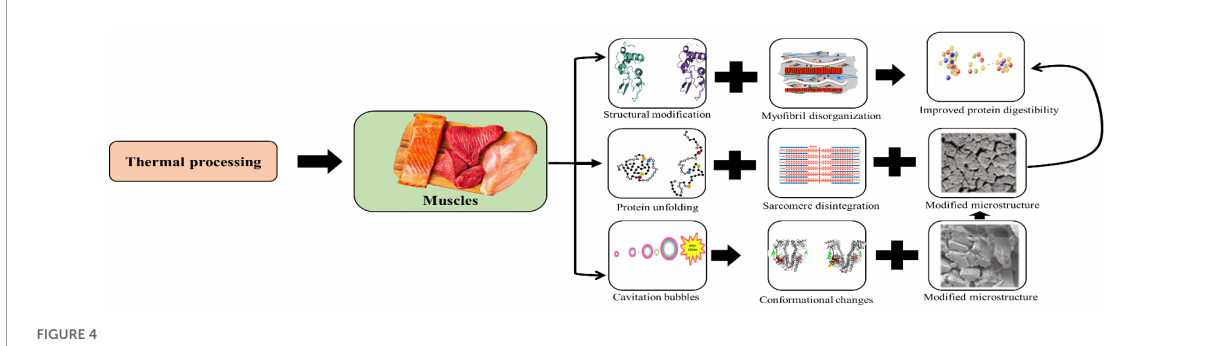
FIGURE4 Effect on protein structure after thermal processing